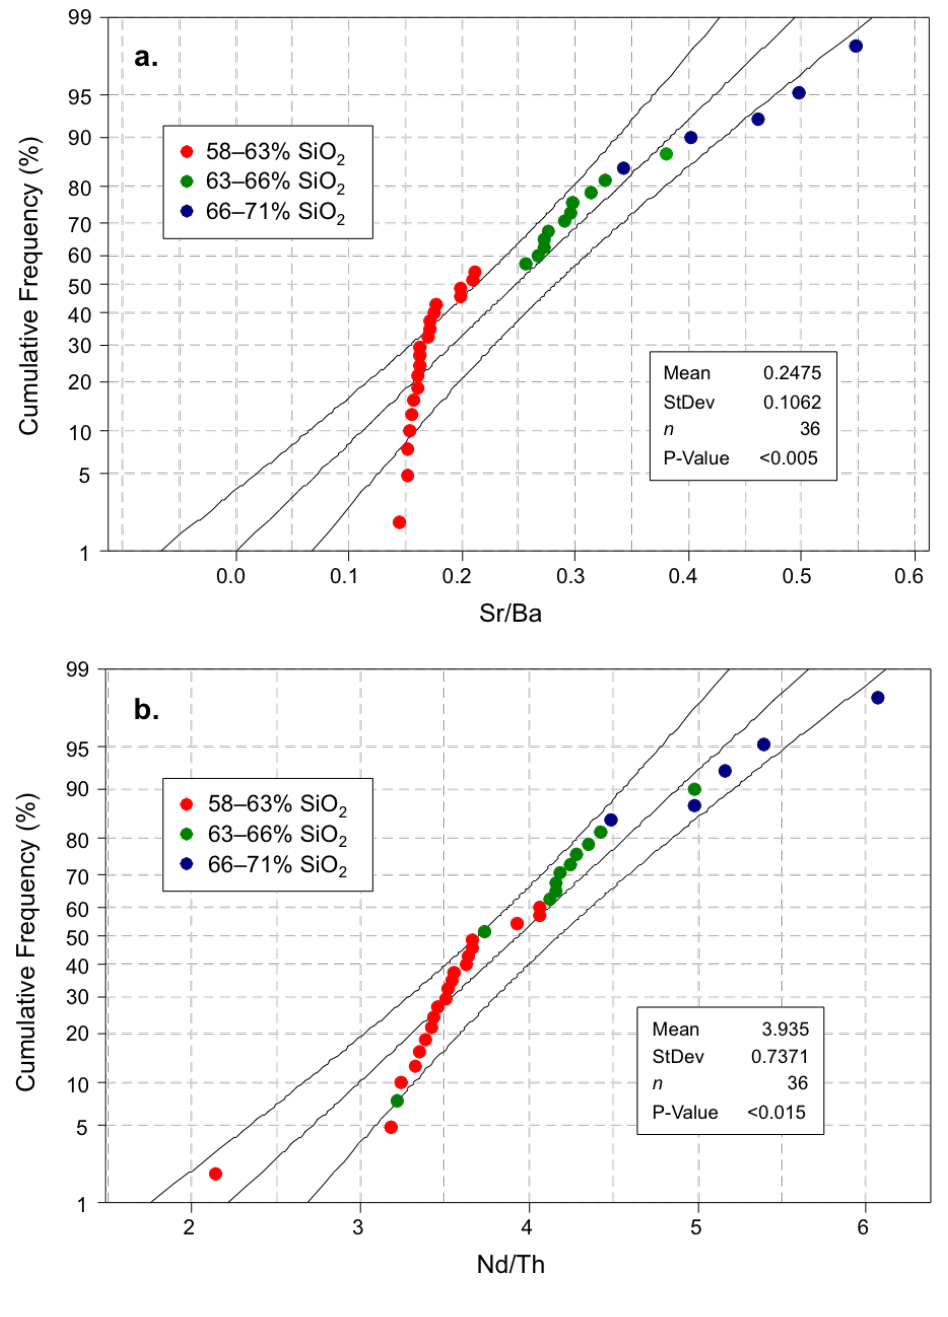
Figure 11. Probability plots (cumulative frequency diagrams that use a log y -axis) for ( a ) Sr/Ba and ( b ) Nd/Th values in bulk rock Papagayo